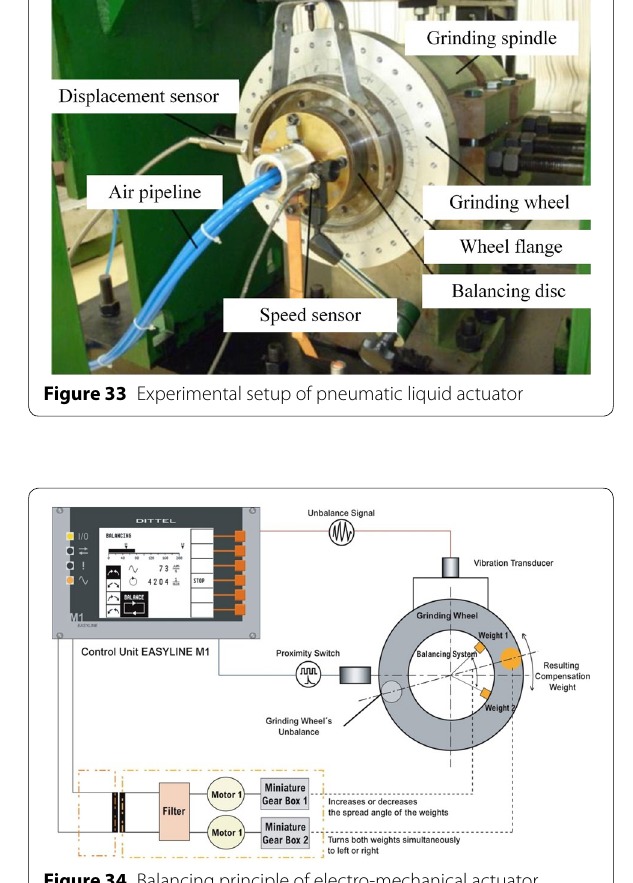
Figure 34 Balancing principle of electro-mechanical actuator